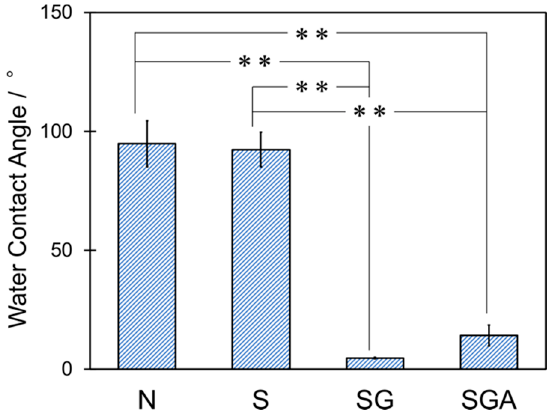
Figure 3. Water contact angle on the surface of Samples N, S, SG and SGA. The symbol ‘**’ indicates p < 0.01 and the no symbol indicates p > 0.05 by one-way ANOVA followed by the Tukey’s tests.